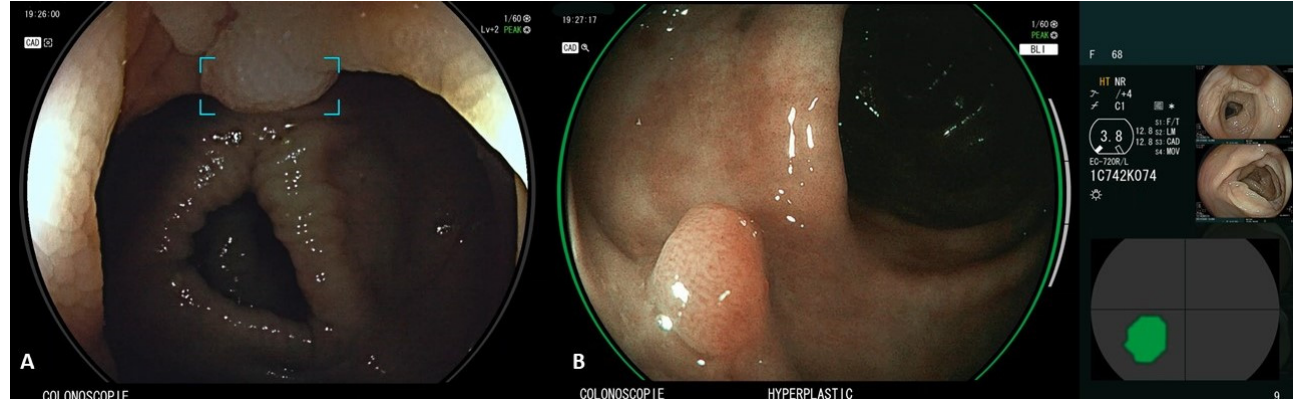
Figure 2. CAD EYE TM Software (Fujifilm, Tokyo, Japan); panel ( A )—CADe function. A polyp is identified in WLI and marked using an annotation box; panel ( B )—CADx function. The polyp is evaluated by CAD EYE in BLI and a diagnosis of hyperplastic polyp is indicated at the bottom of the monitor screen. The position and outline of the polyp is also indicated in the lower right part of the monitor.